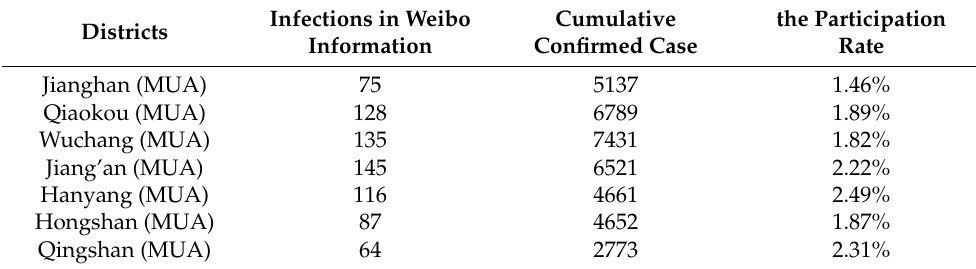
Table 3. The participation rates in the helpline among the COVID infected.